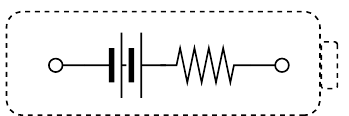
Figure 3. Cell’s internal resistance simplified model.